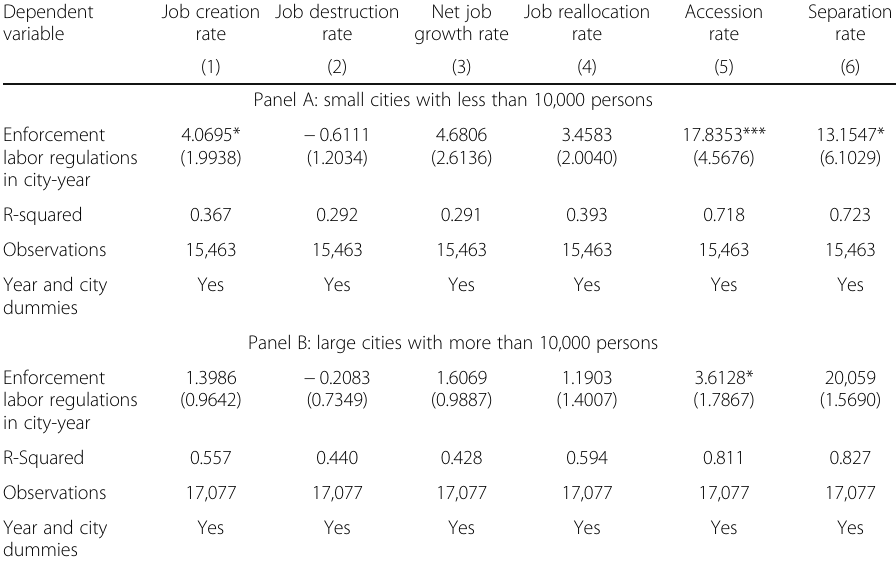
Table 10 Enforcement of labor regulations and job flow rates, by average population size in the city Dependent Job creation variable